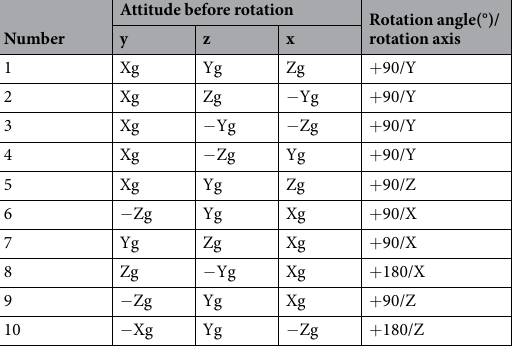
Table 1. The designed 10-position rotations of the calibration trajectory.